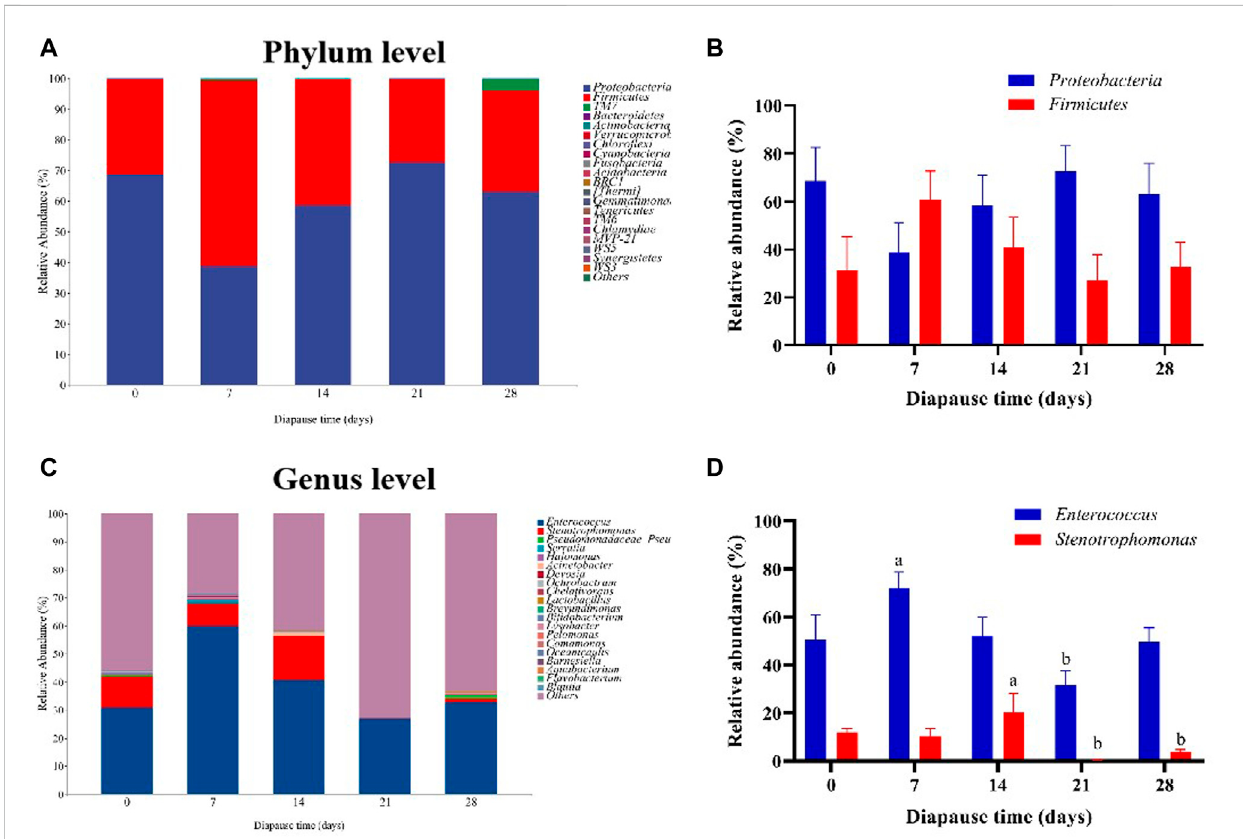
FIGURE 4 Effectofdiapausetimeonthecompositionsandrelativeabundanceofgutmicrobiotain C.bilineatatsingtauica larvae.Thecompositions (A) andthe relative abundance (B) of Proteobacteria and Firmicutes at the phylum level; the compositions (C) and the relative abundance (D) of Enterococcus and Stenotrophomonas at the genus level. Different lowercase letters denote signi fi cant difference among diapause time by Tukey test at p <